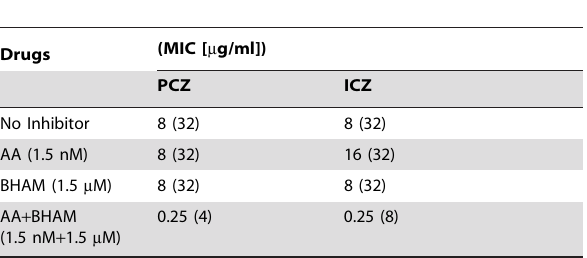
Table 1. Effects of AA and BHAM at inhibitory concentrations on the MICs of PCZ and ICZ against R. oryzae spores in RPMI 1640